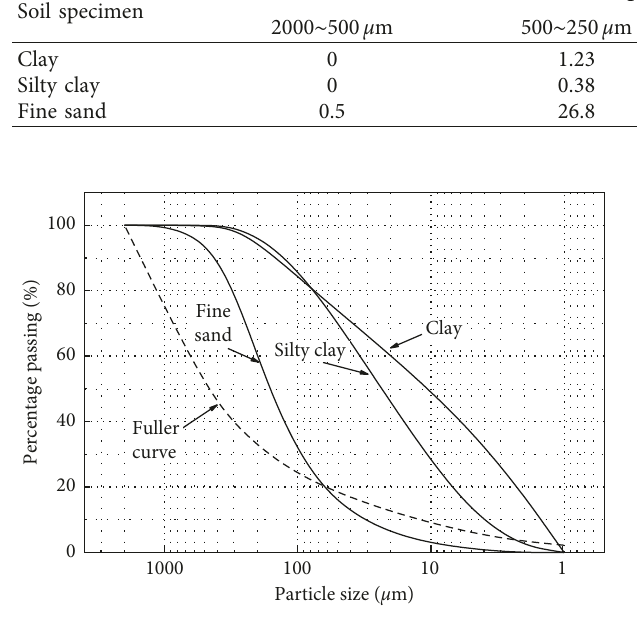
Figure 5: Gradation curve of three soil specimens. Table 6: Composition of mixed soil specimens.